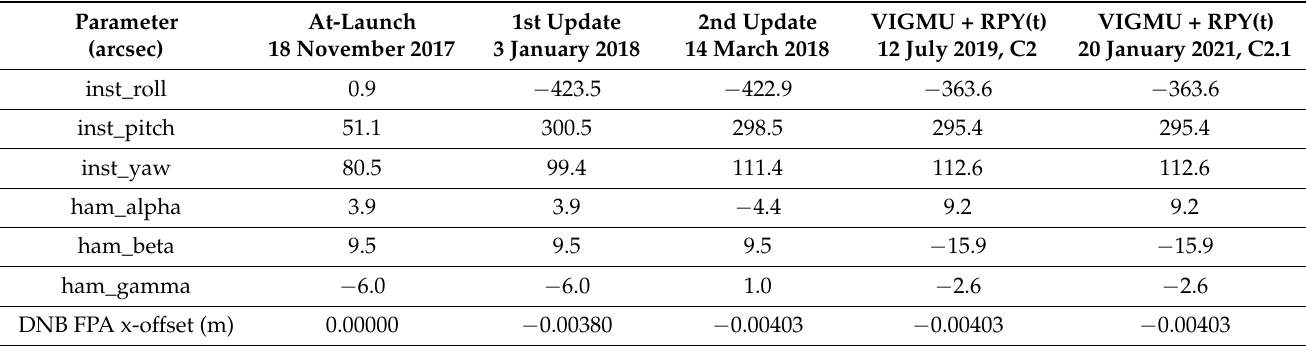
Table 2. List of major NOAA-20 VIIRS geolocation parameter